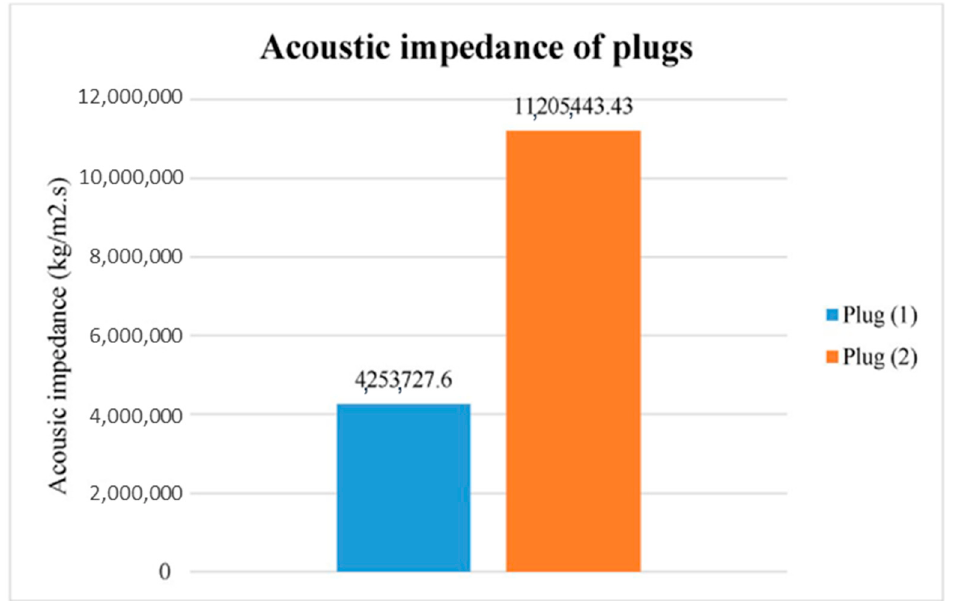
Figure 6. Measured acoustic impedance of plugs (reprinted from Karami et al. [27] Copyright 2020, LN 5341881023037, with permission from Elsevier) .